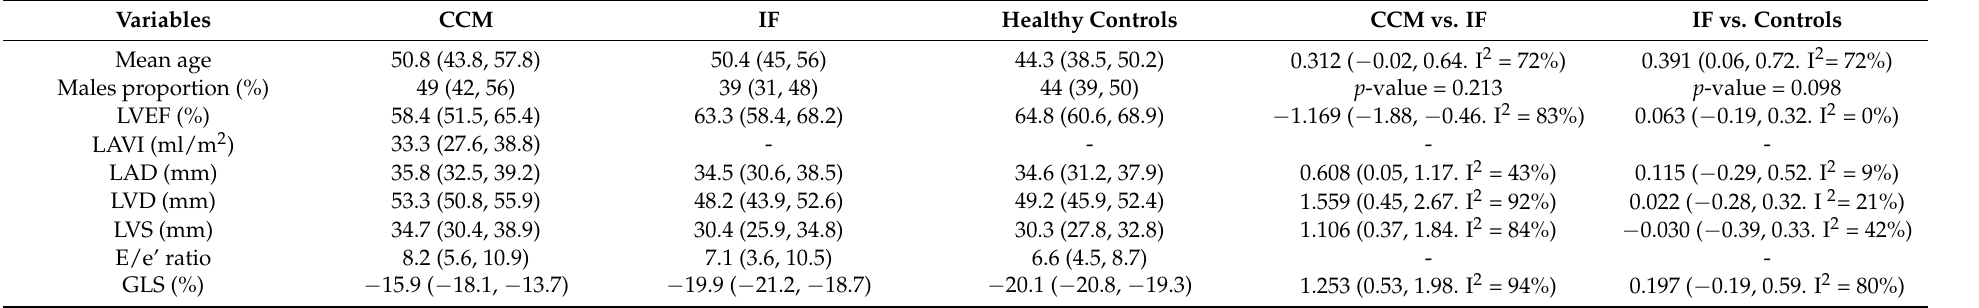
Table 2. Baseline echocardiographic characteristics of patients assessed in the included studies and differences between the